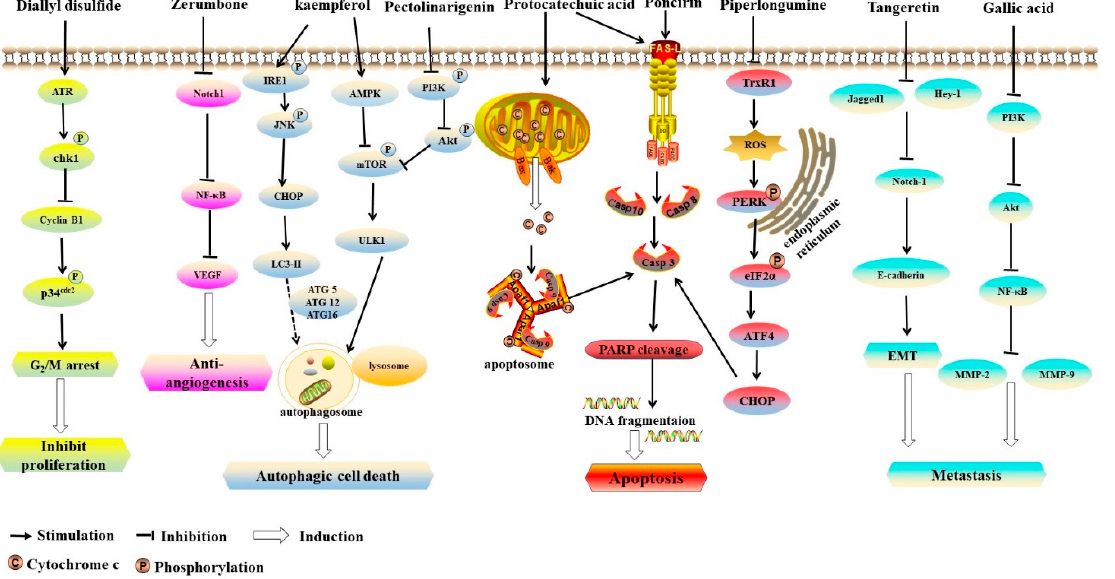
Figure 2. The anticancer mechanisms of phytochemicals on gastric cancer. Diallyl disulfide induced G 2 /M arrest by activating MAPK pathway. Zerumbone showed anti-angiogenesis activity via the inhibition of Notch1/NF- κ B/VEGF pathway. Kaempferol induced autophagic cell death via IRE1/JNK/CHOP and AMPK/ULK1 pathways. Pectolinarigenin induced autophagic cell death via PI3K/Akt/mTOR pathway. Poncirin induced apoptosis via the death receptor pathway. Piperlongumine induced apoptosis via ROS-triggered ER-stress and mitochondrial dysfunction, while protocatechuic acid induced apoptosis either through Fas/FasL death receptor or mitochondrial pathways. Tangeretin inhibited migration and invasion by reducing the expressions of Notch-1, Jagged1/2 and Hey-1. Gallic acid could suppress metastasis by downregulating PI3K/Akt pathway.